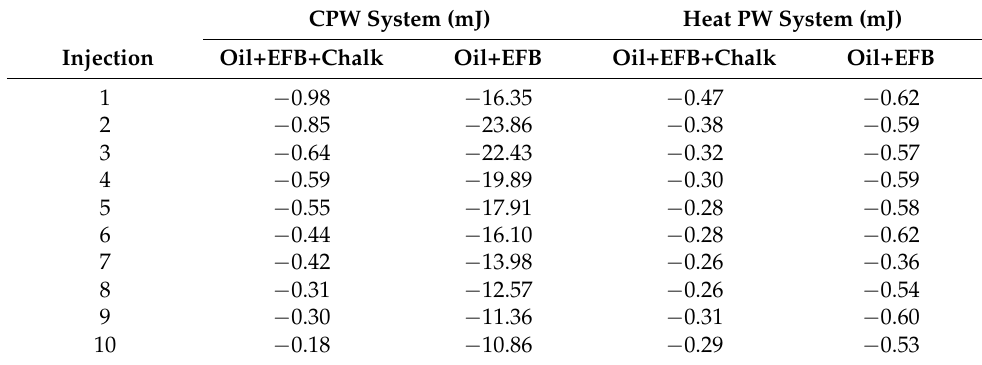
Table 6. Heat values for rock–fluid and fluid–fluid